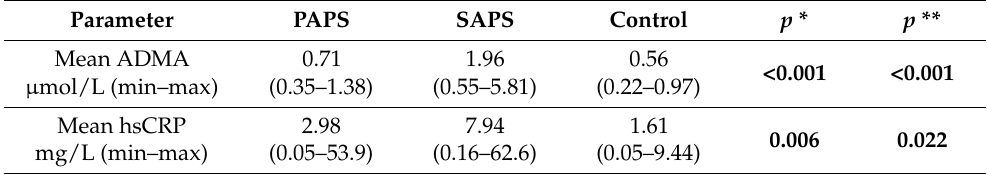
Table 3. Concentrations of ADMA and hsCRP.